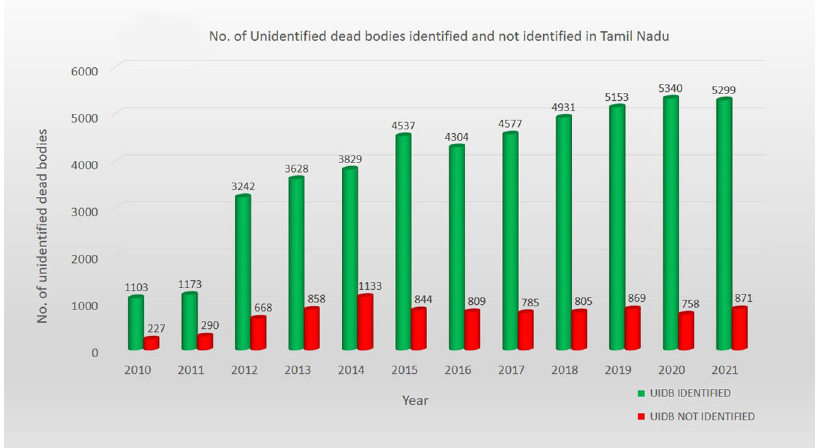
Fig. 3 Number of unidenti fi ed dead body (UIDB) cases (traced and not traced) in Tamil Nadu during the decade 2010 – 2021. x -axis: year. y -axis: number of UIDB cases in Tamil Nadu.